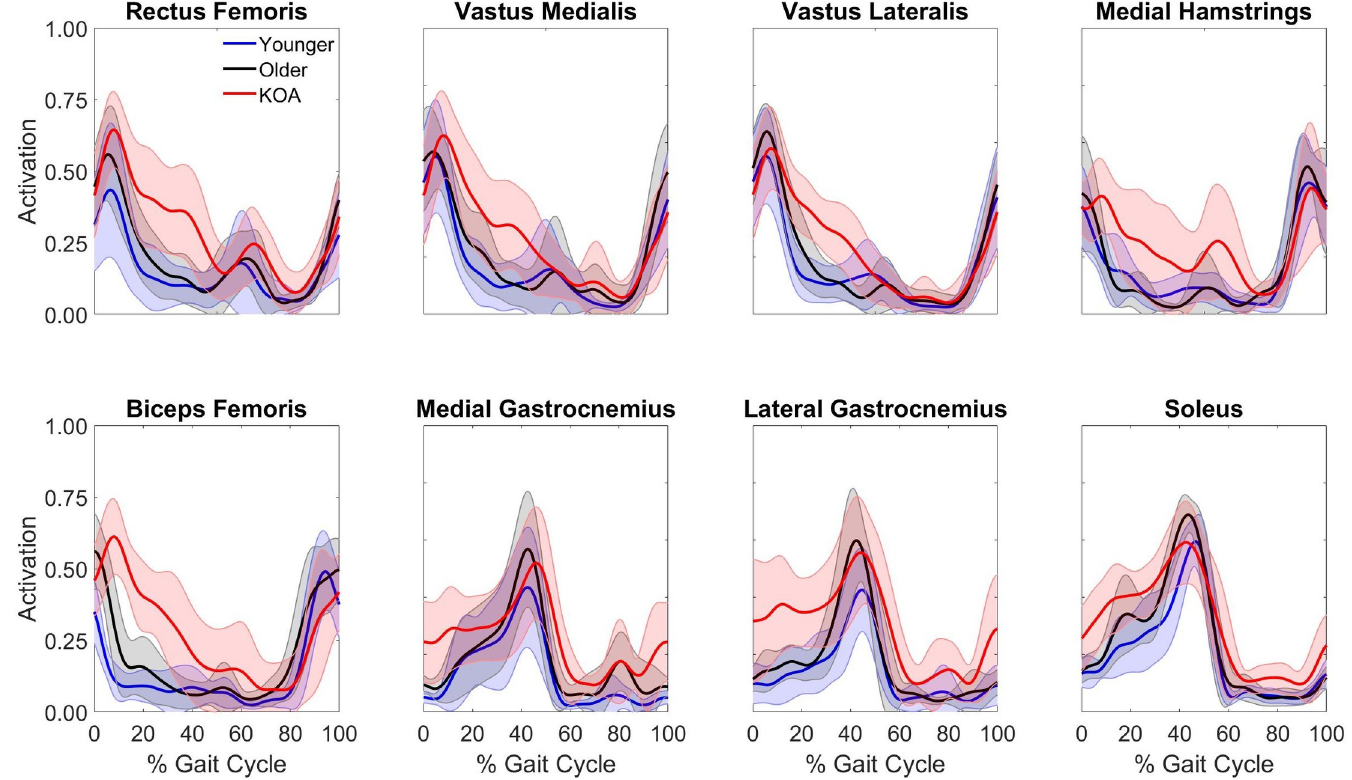
Fig 1. Average normalized EMG of young adults, older adults, and KOA patients. Solid lines represent population average. Shaded areas represent ± one standard